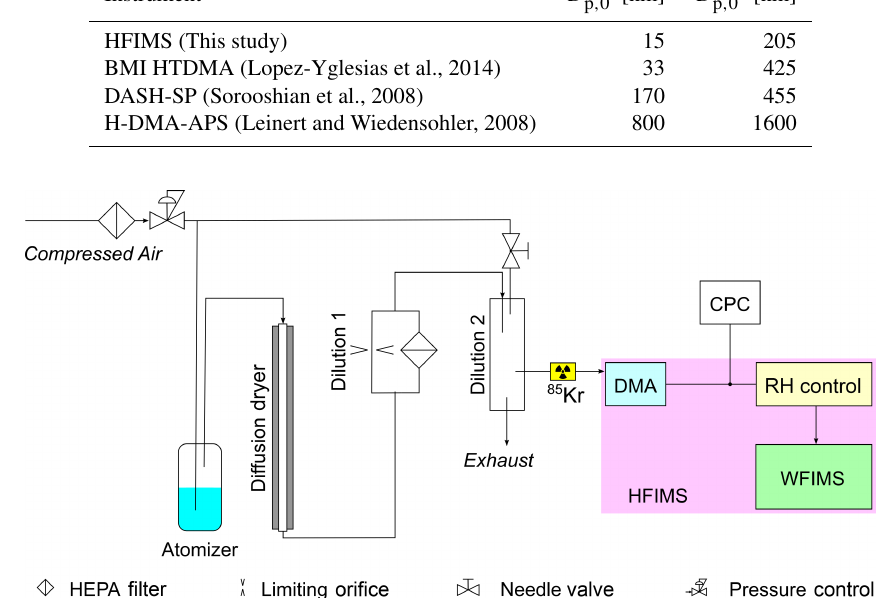
Figure 3. Experimental setup for laboratory characterization of the